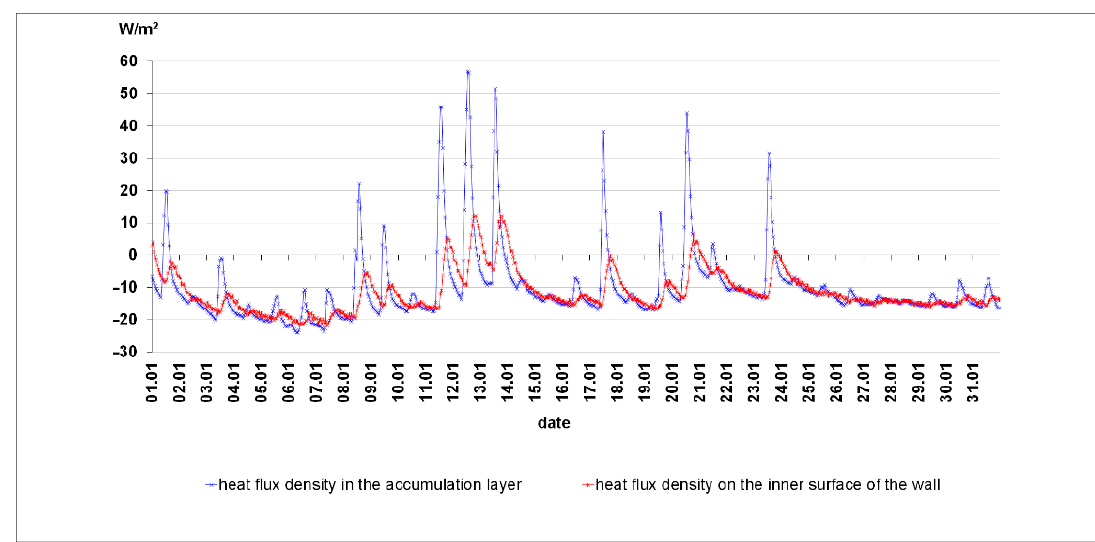
Figure 18. Graph of heat flux density flowing through the storage layer and on the inner surface of the wall in January.